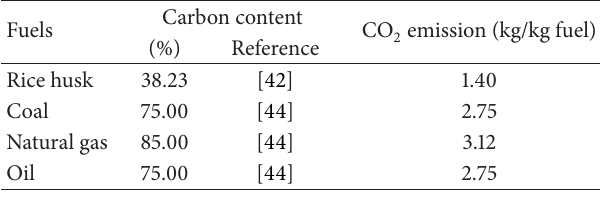
production from various fuels. 2